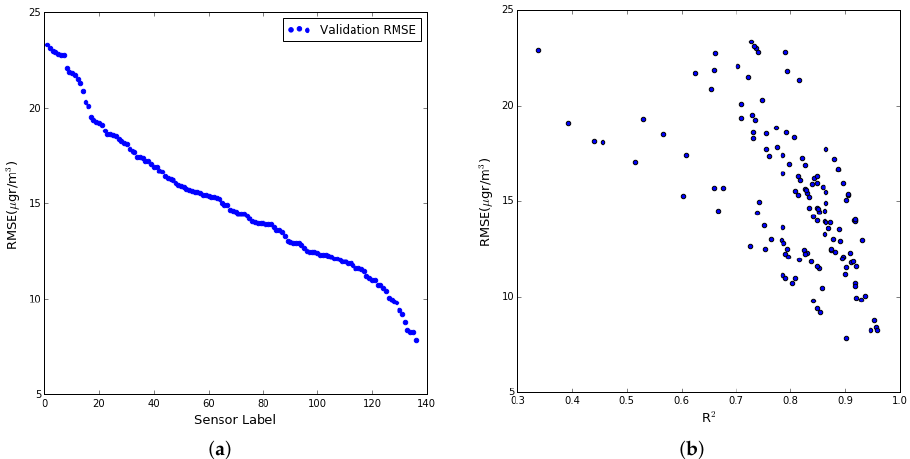
Figure 2. ( a ) RMSE for the set of sensors, ( b ) RMSE versus correlation coefficient ( R 2 ).